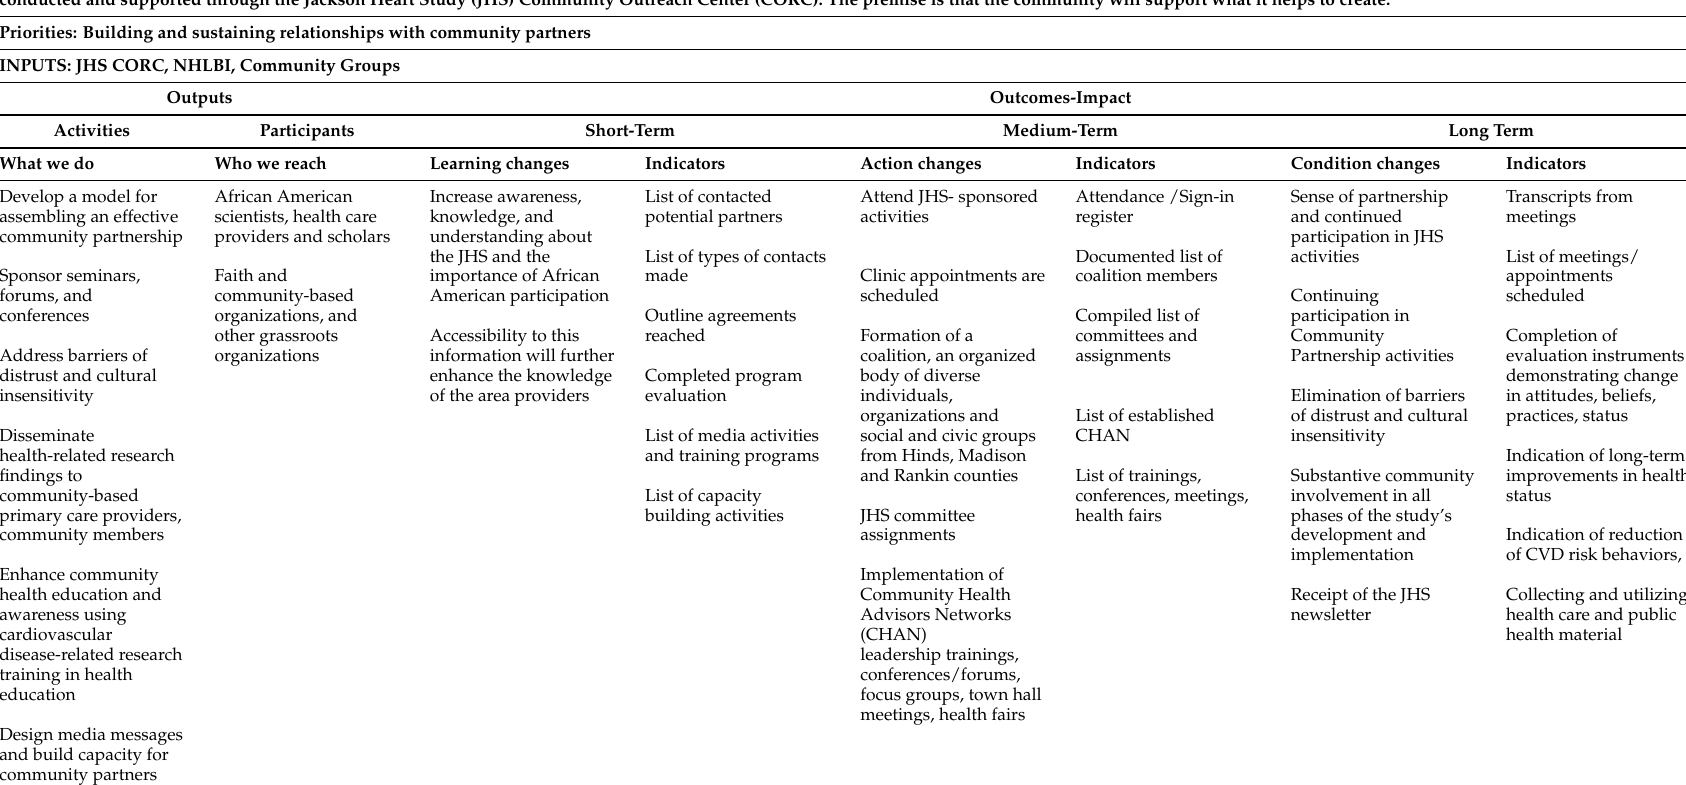
Table 1. Community outreach center (CORC) logic model 1. Logic model: building institution and community partnership/commitment. SITUATION: Developing institutional and community commitment to CBPR through facilitating respect for the knowledge and expertise the community brings to the table. Outreach programs and activities are conducted and supported through the Jackson Heart Study (JHS) Community Outreach Center (CORC). The premise is that the community will support what it helps to create. Priorities: Building and sustaining relationships with community